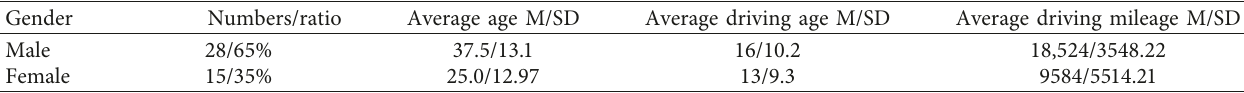
Table 1: Drivers’